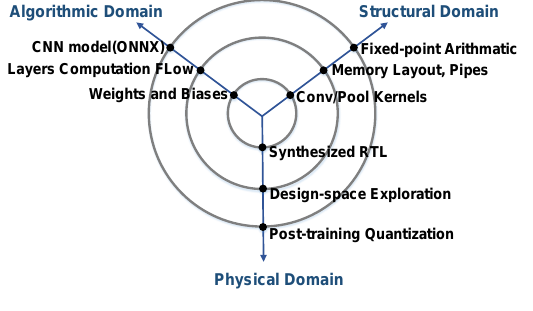
Figure 5. Gajski–Kuhn chart illustrating different aspects of